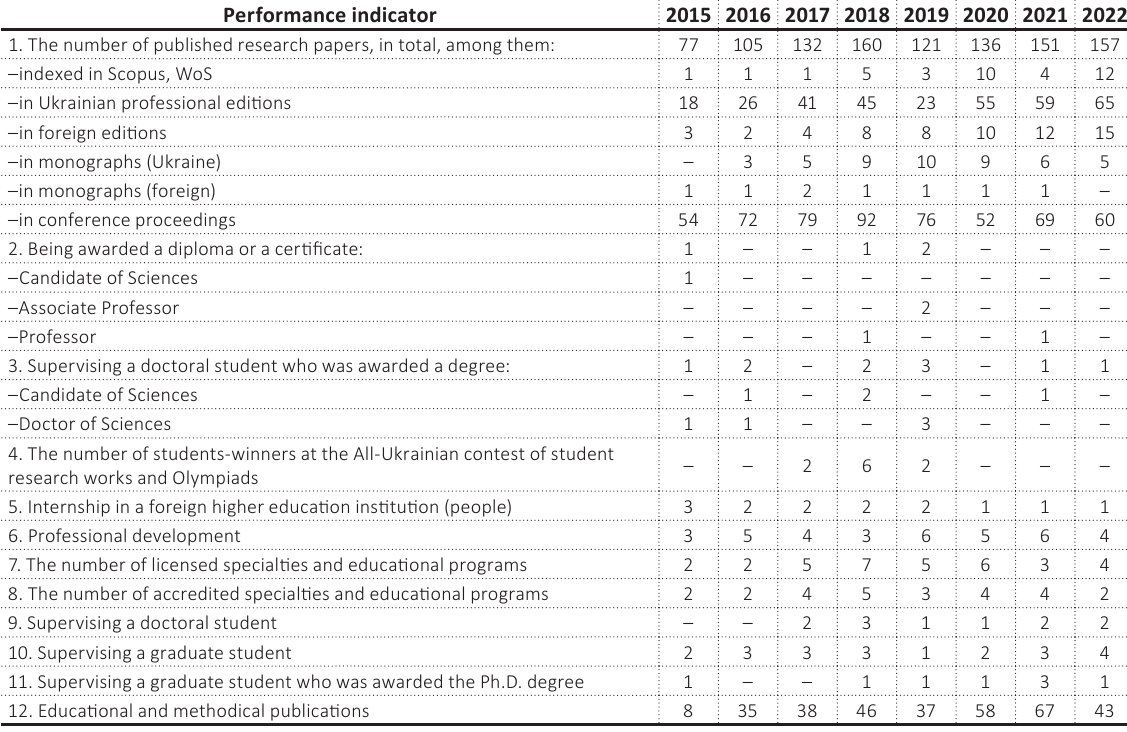
Source: Questionnaire